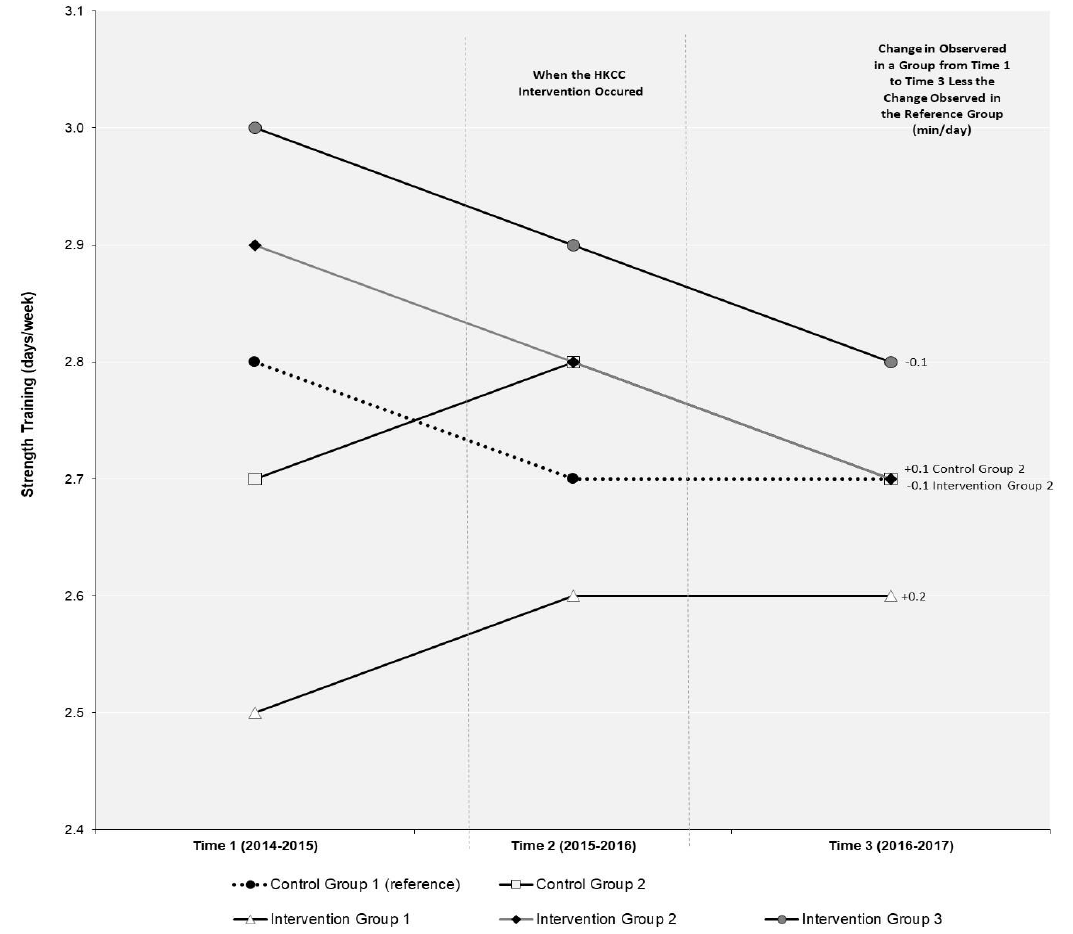
Figure 3. Difference-in-difference (DID) evaluation of the impact of the Healthy Kids Community Challenge (HKCC) on strength training over time in a repeat cross-sectional sample of students in the COMPASS study (2014–2015 to 2016–2017). DID measures the differential effect of one or more groups relative to a “reference group” in a natural experiment. In a DID analysis, the effect of group membership on the outcome can be calculated by comparing the mean change over time in the outcome variable for a particular group (i.e., intervention or extra control group) compared to the change observed over time for the outcome variable in the reference group. The DID value represents the additional change in an outcome observed in that group above or below the change that occurred in the reference group.